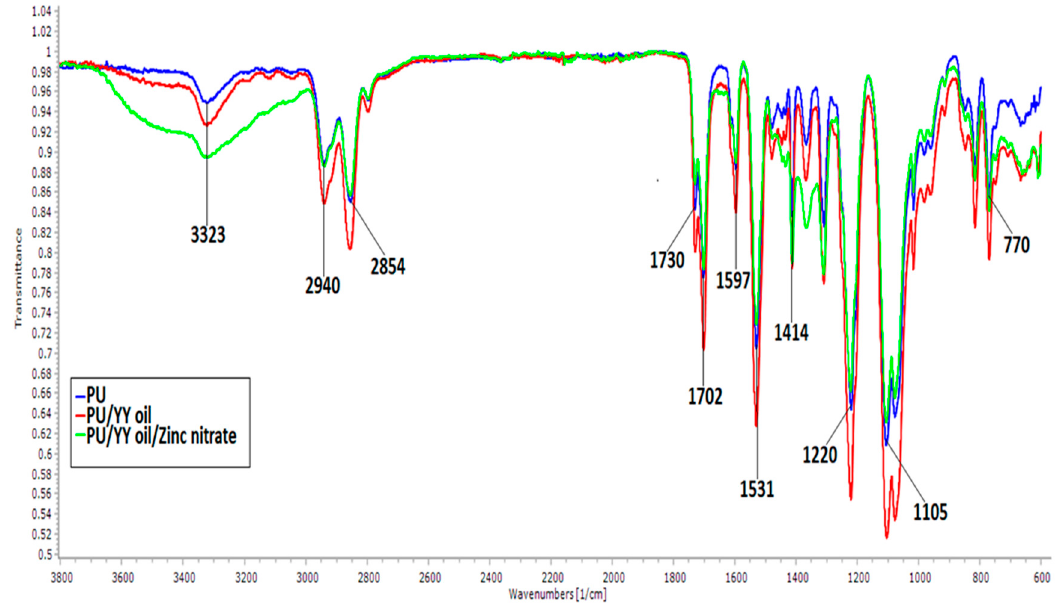
Figure 3. Fourier Transform Infrared Spectroscopy (FTIR) of PU, PU/YY and PU/YY/ZnNO 3.